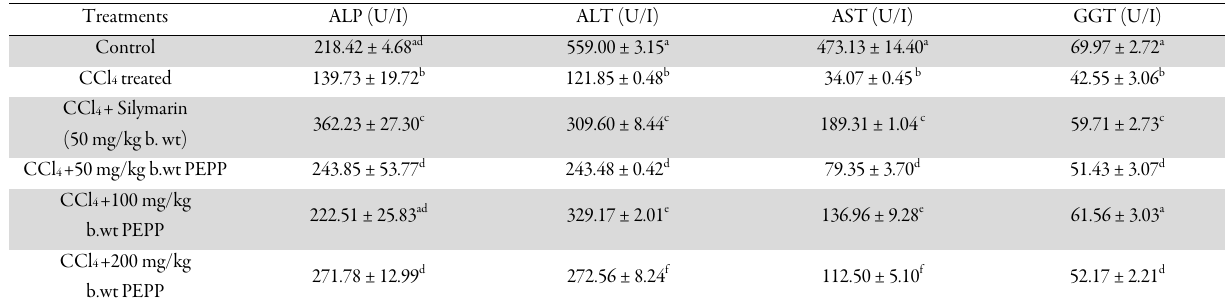
Values are expressed as means of 5 replicates ± SEM. Values with the same superscript along the column are not significantly different (p < 0.05). ALP: alkaline phosphatase; ALT: alanine aminotransferase;AST: aspartate aminotransferase; GGT: gamma glutamyl transferase. Table 4. Effects of polyphenolic extract of Paullinia pinnata leafs on some liver function indices of CCl4-treated hepatotoxic rats Treatments